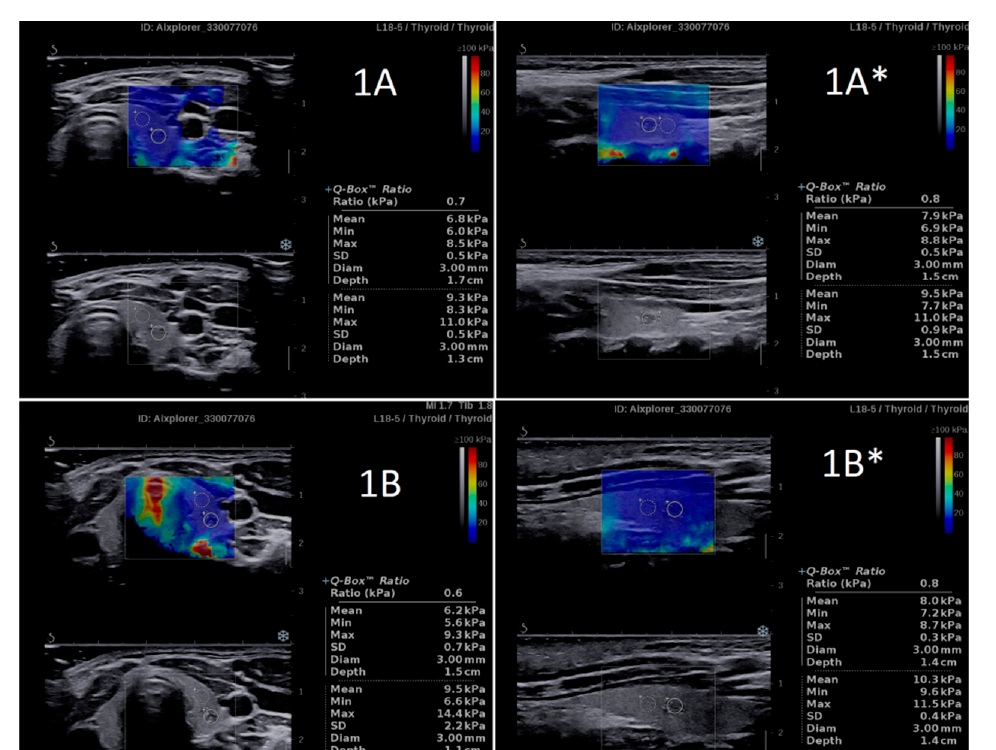
Table 1. Comparison between SWS and SWR values obtained by two independent researchers.